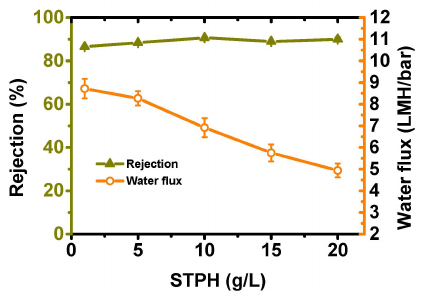
Figure 7. Recovery performance by nanofiltration